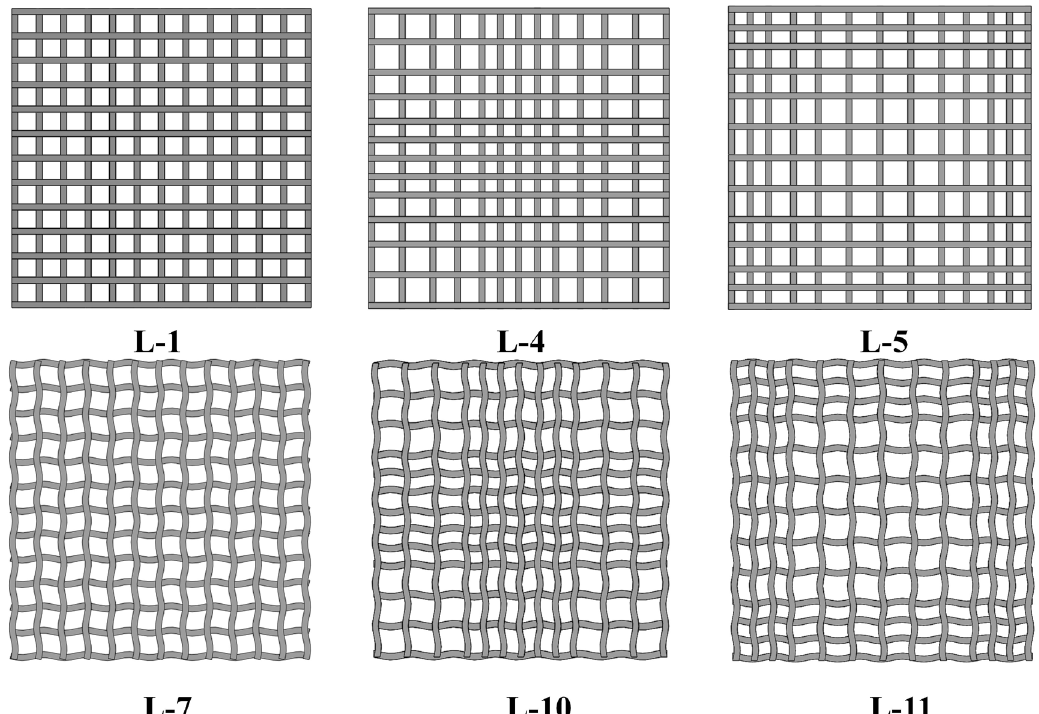
Figure 12. Plane diagrams of specimens with different gradient form strut distances.